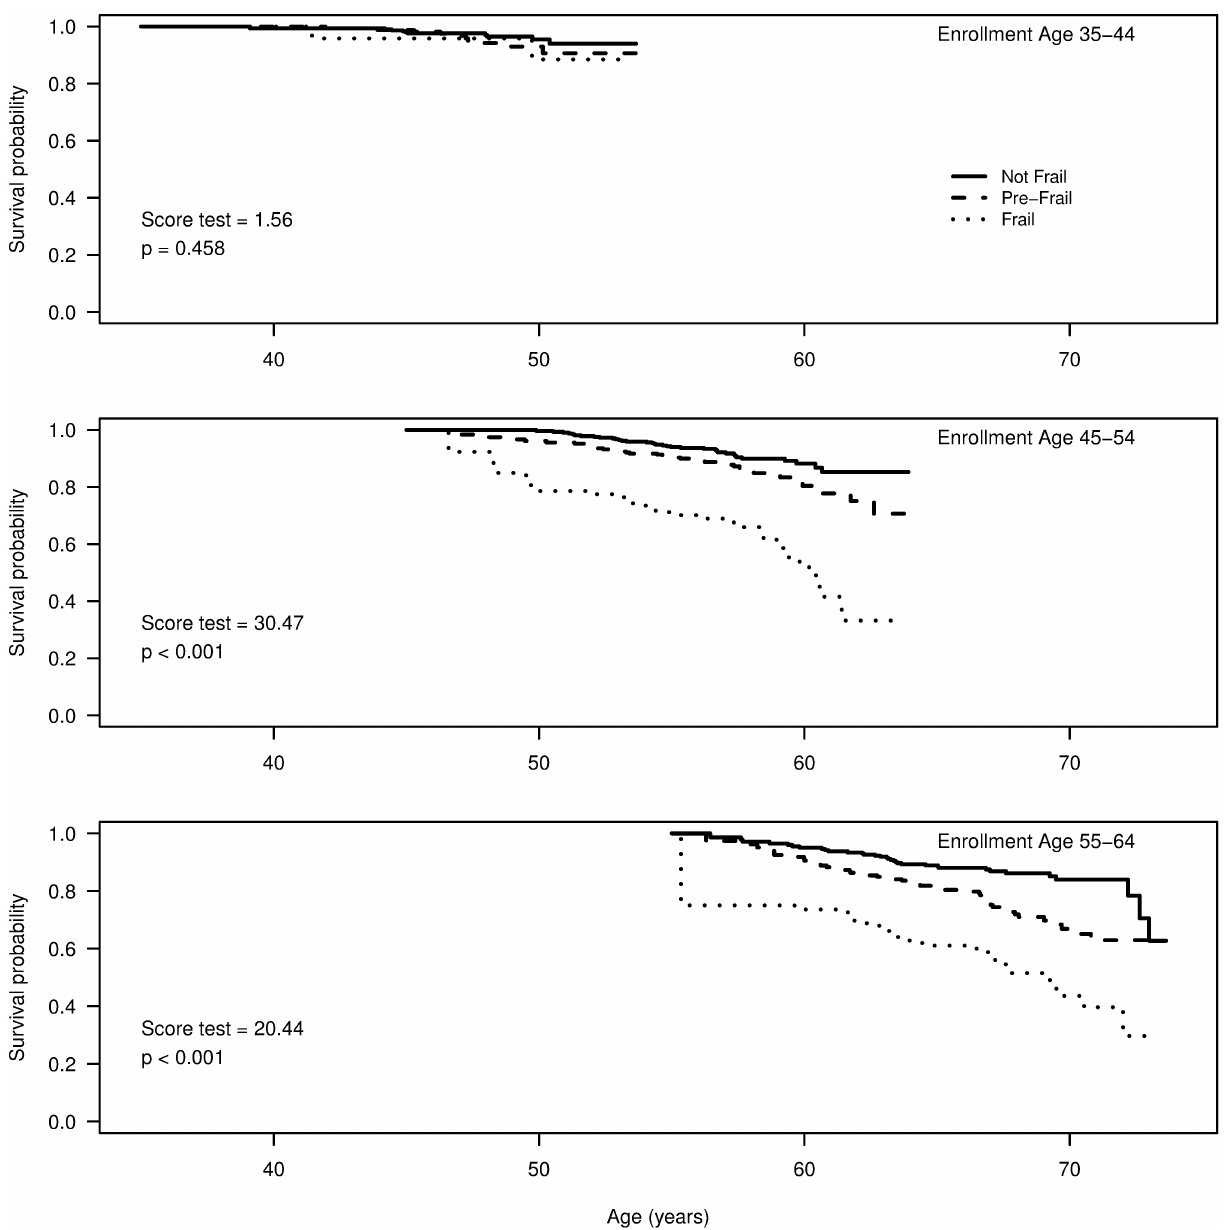
Fig 1. Overall survival by initial frailty group, stratified by age at